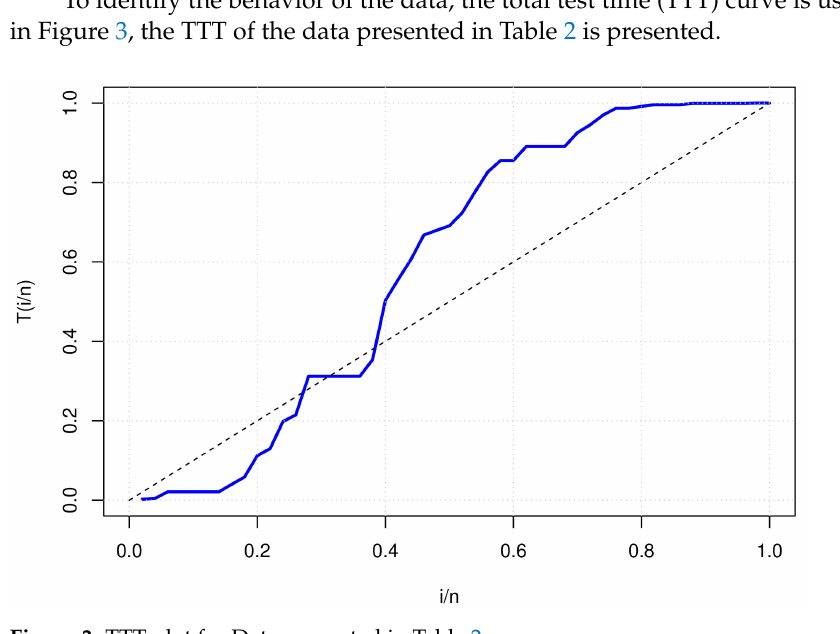
Figure 3. TTT plot for Data presented in Table